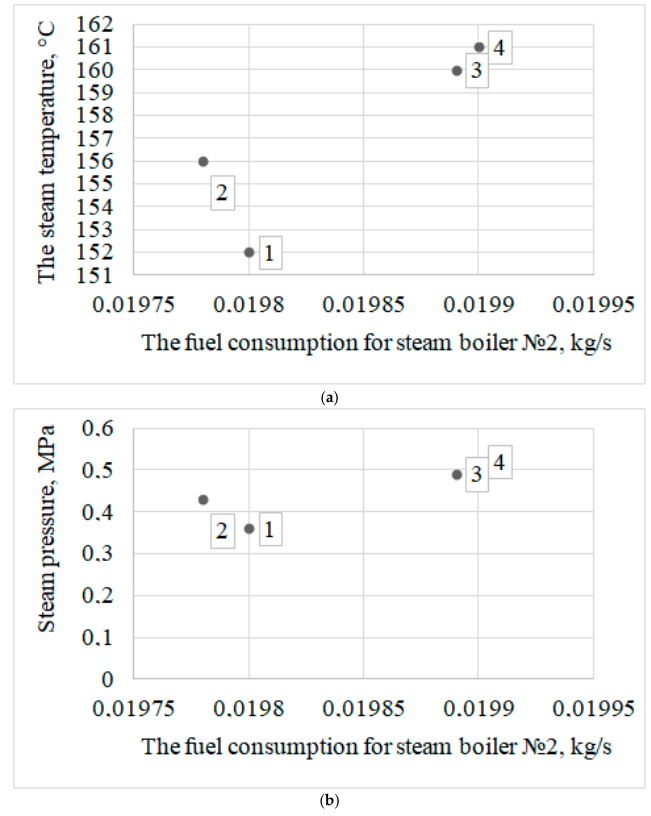
Figure 11. Relationship between parameters in Steam boiler 2: ( a ) relationship between steam temperature and fuel consumption, ( b ) relationship between steam pressure and fuel.